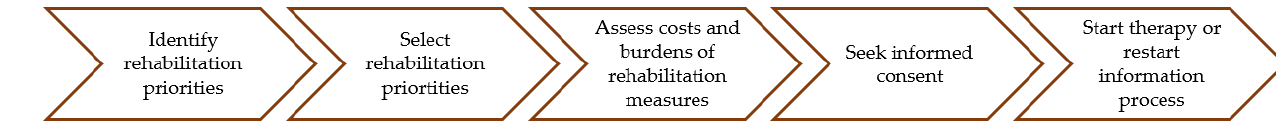
Figure 5. Process from identification, selection, cost and burden assessment, to seeking informed consent and starting the rehabilitation process.